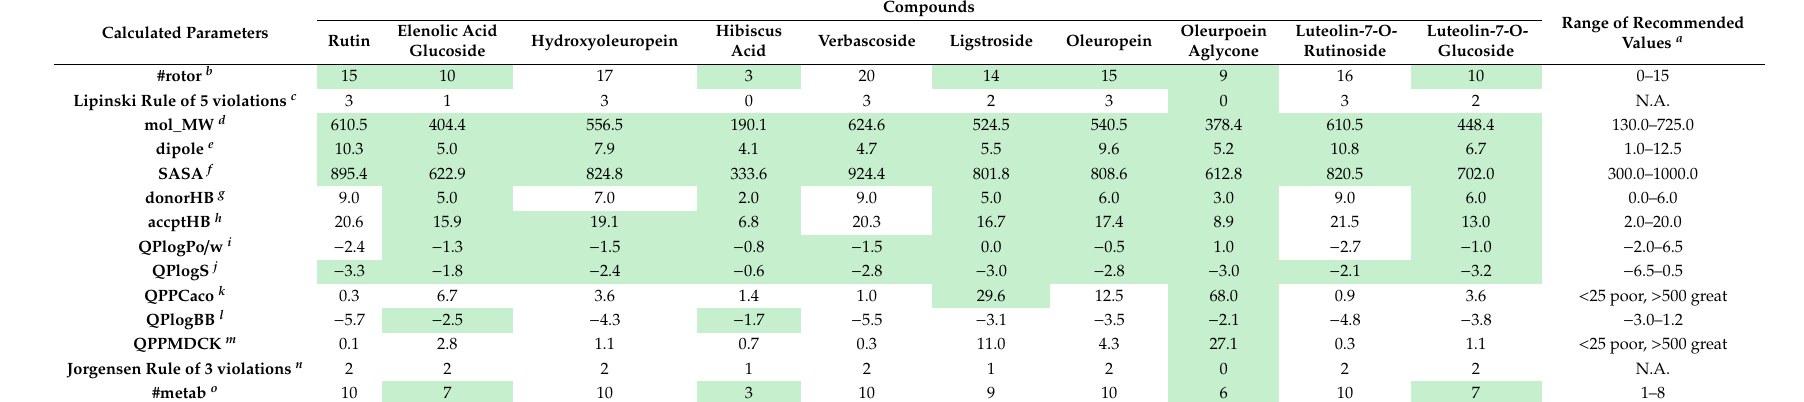
Table 1. Predicted physico-chemical parameters for all the PRES